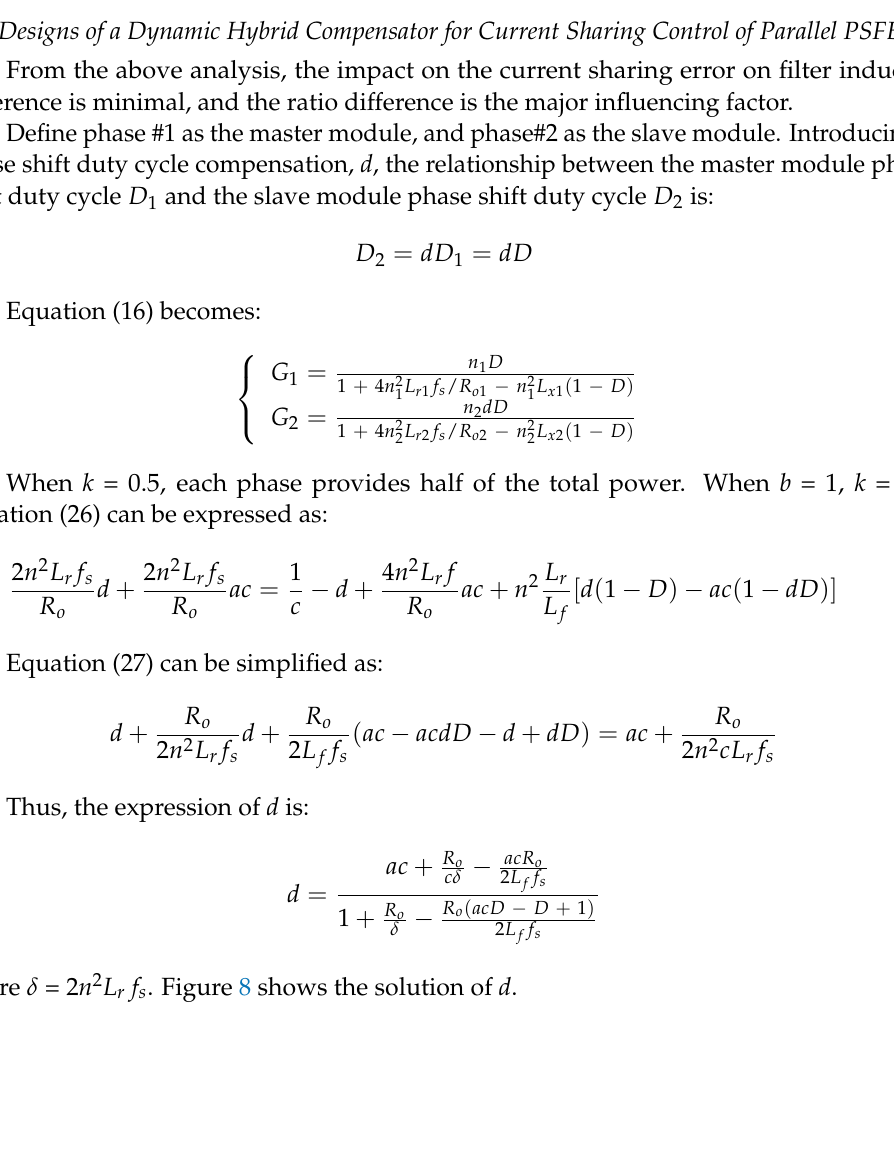
Figure 7. Solutions of k for different values of c at different output resistances.